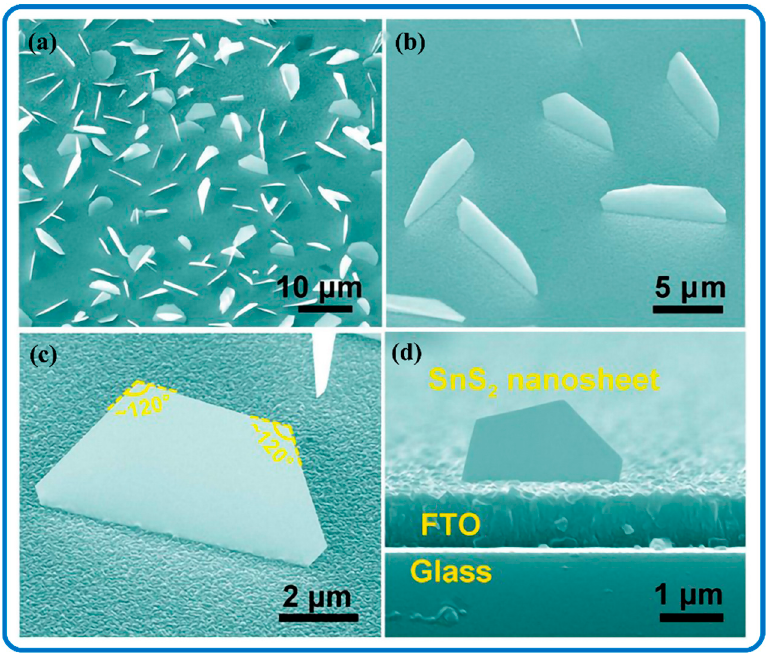
Figure 6. ( a , b ) Low-magnification SEM images. ( c ) High-magnification SEM image of vertical SnS 2 nanosheet taken at 45° from a normal viewing angle. ( d ) Typical cross-sectional-view SEM image of one vertical SnS 2 nanosheet grown on FTO substrate. Reproduced with permission from [126]. Copyright 2017, Royal Society of Chemistry.